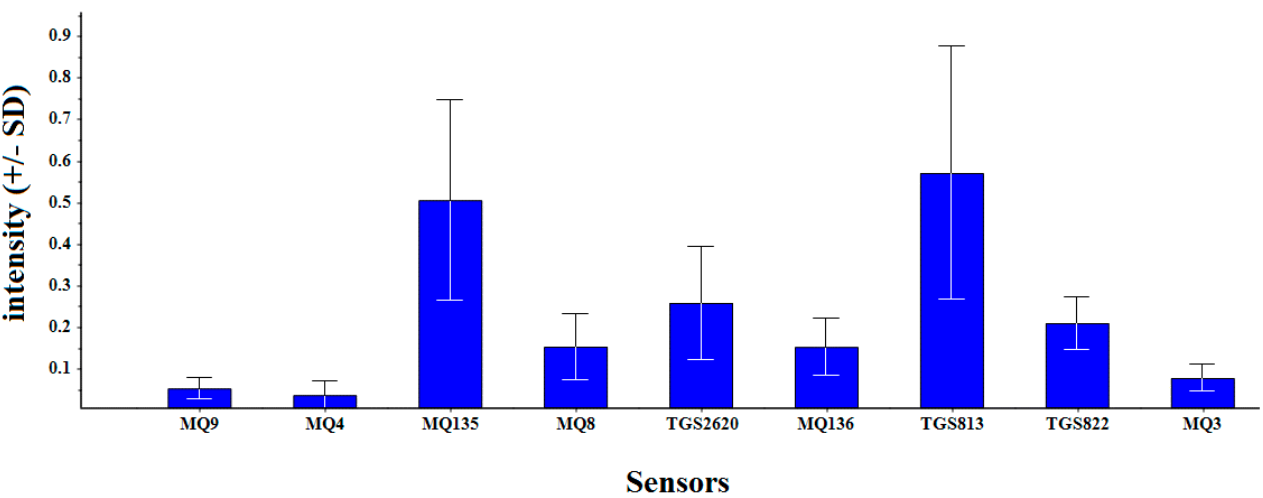
Figure 2. Radar graph of sensor relative-intensity responses to different types of essential oils obtained from sensor array output of MAU-9 MOS e-nose.